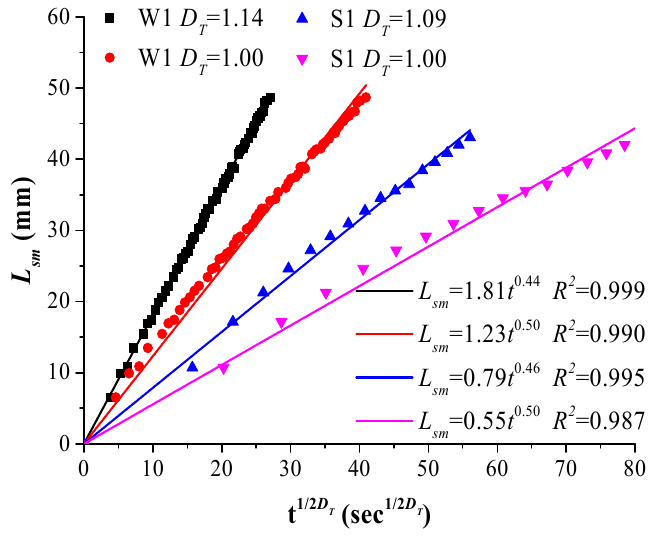
Figure 8. Plots of L sm versus t 1 / 2 D T for two kinds of specimens. Table 5. Sorptivity ( C m ) and goodness-of-fit (R 2 ) parameters of the fine sandstone (W1) and silty sandstone (S1).